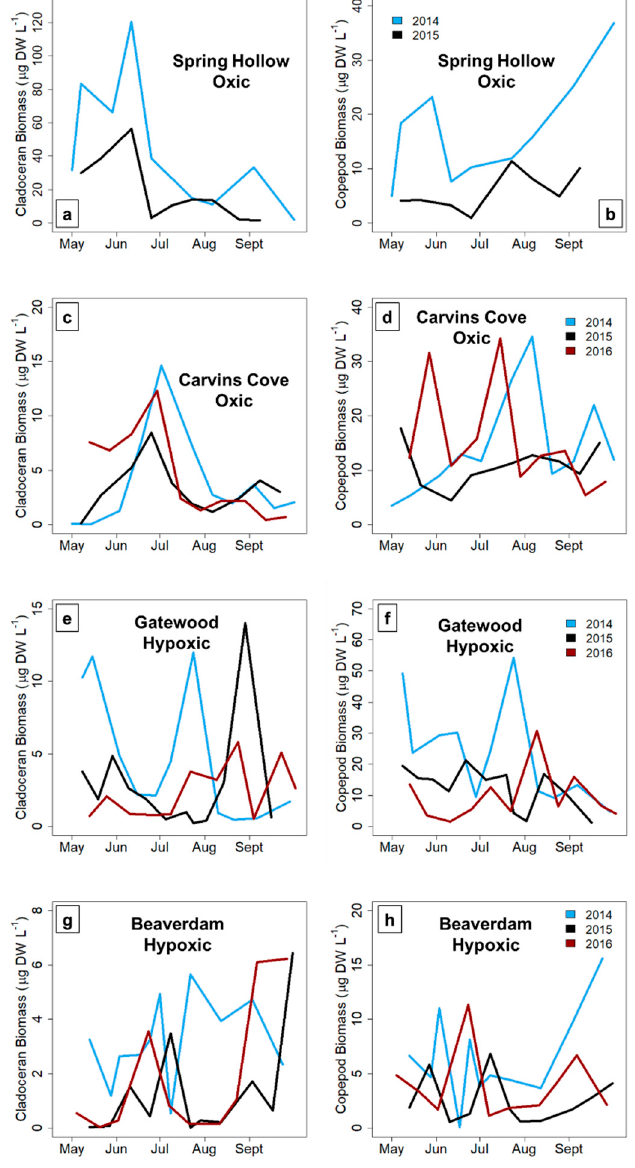
Figure A3. Seasonal and inter-annual cladoceran and copepod biomass dynamics in the two seasonally oxic reservoirs (Spring Hollow: A , B ; Carvins Cove: C , D ) and the two seasonally hypoxic reservoirs (Gatewood: E , F ; Beaverdam: G , H ). Note the differences in the range of biomass between the reservoirs.